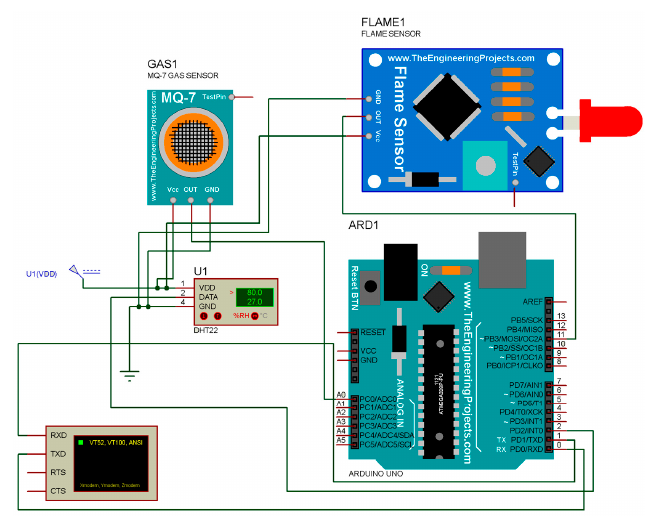
Figure 14. Proteus simulation. Table 6. Experimental analysis of CR-Temp(C).